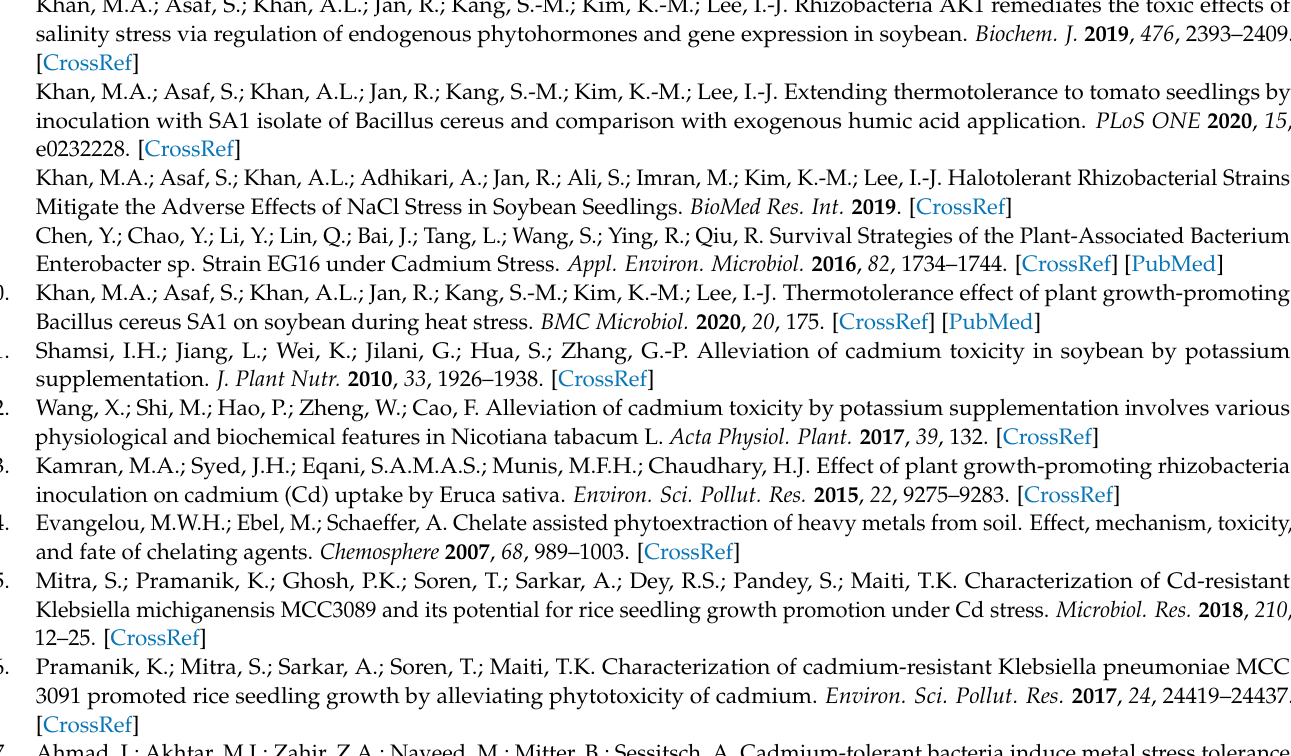
quantification of the SA, Table S3: Description of plant species and isolates of rhizospheric bacteria along with their number having individual or multiple plant growth-promoting